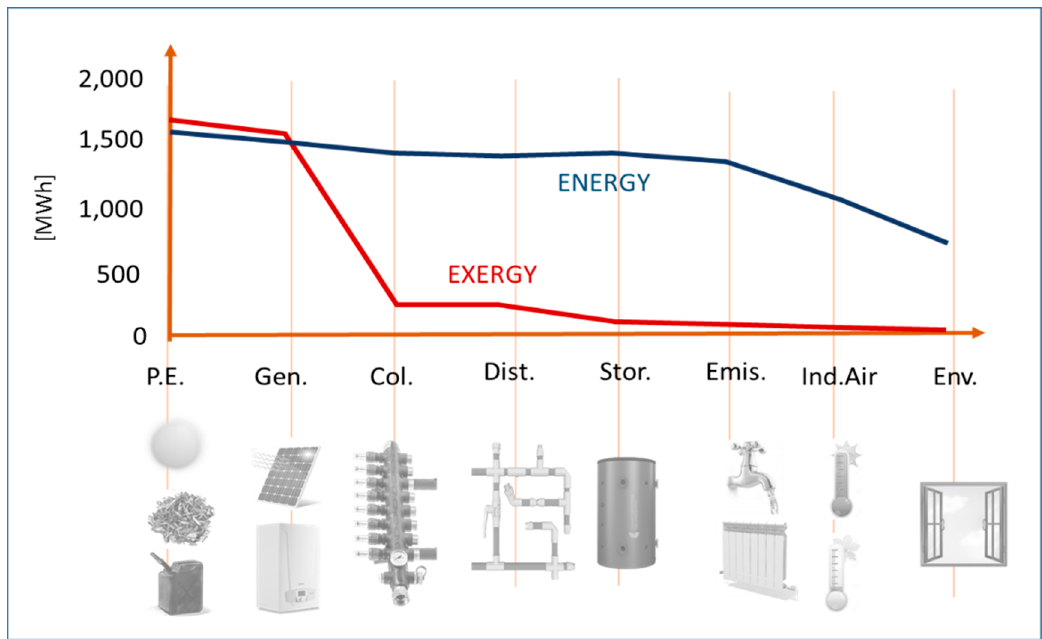
Figure 1. Profile of annual energy and exergy flows in a heating and domestic hot water (DHW) facility .